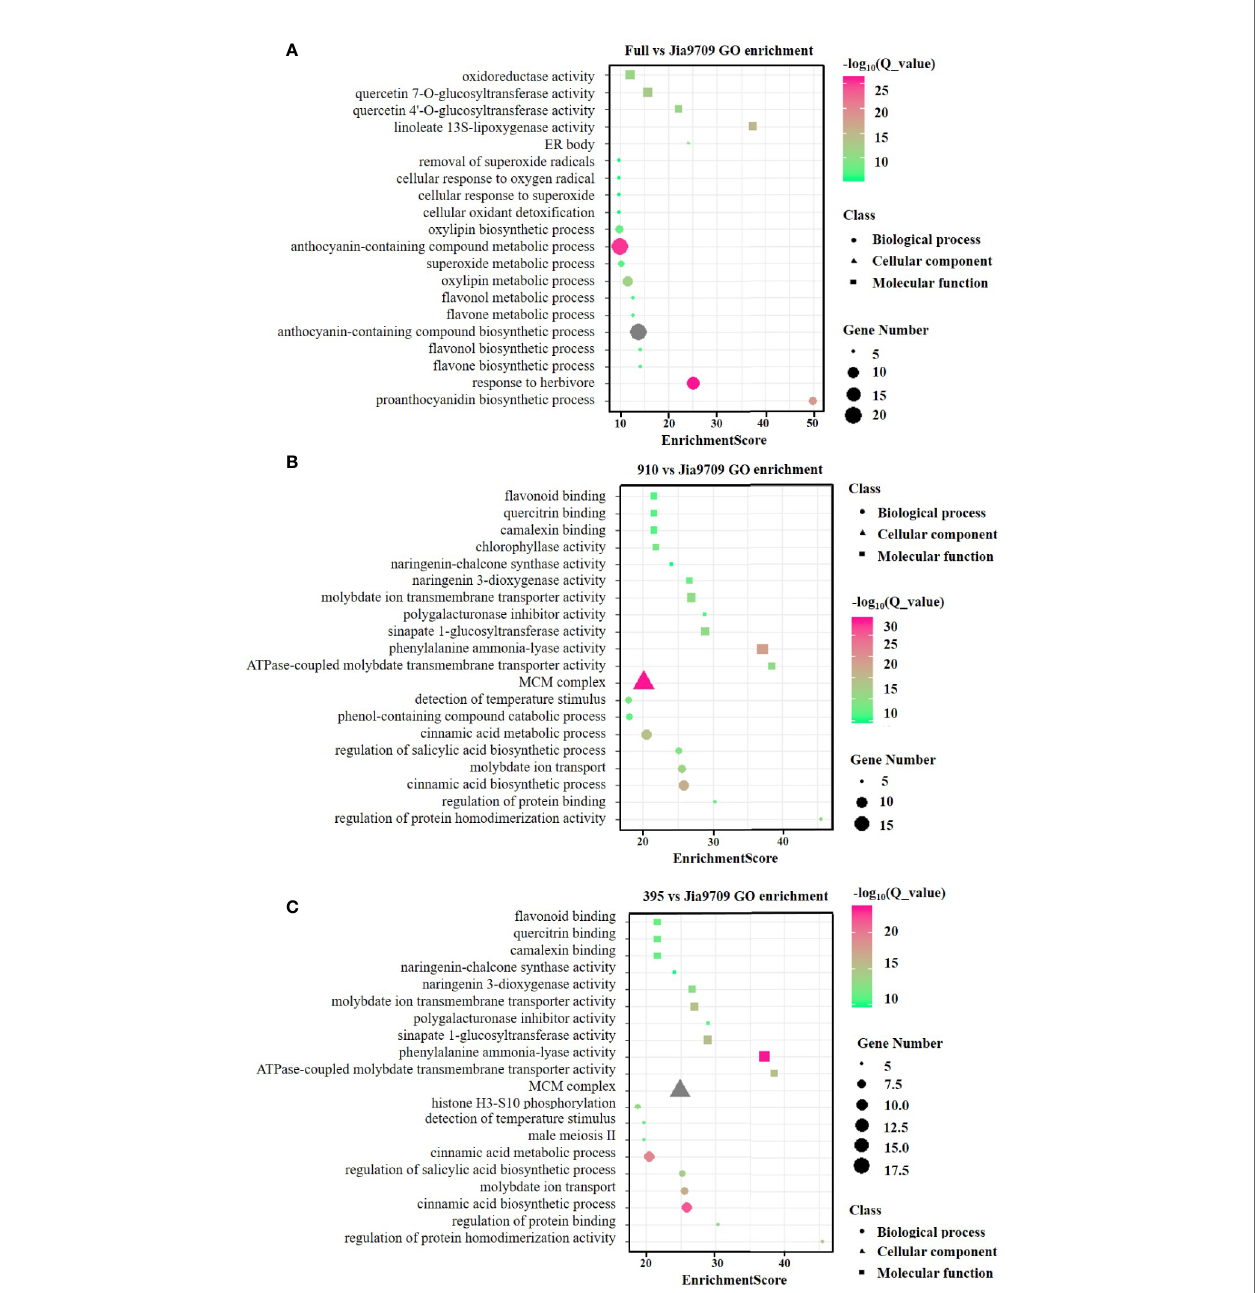
FIGURE 8 | GO enrichment analysis of the DEGs in transgenic lines. (A-C) Top twenty enriched GO categories of DEGs in full-length BnPAP2.A7 transgenic lines (A) , 395 (B) , and 910 (C) isoform transgenic